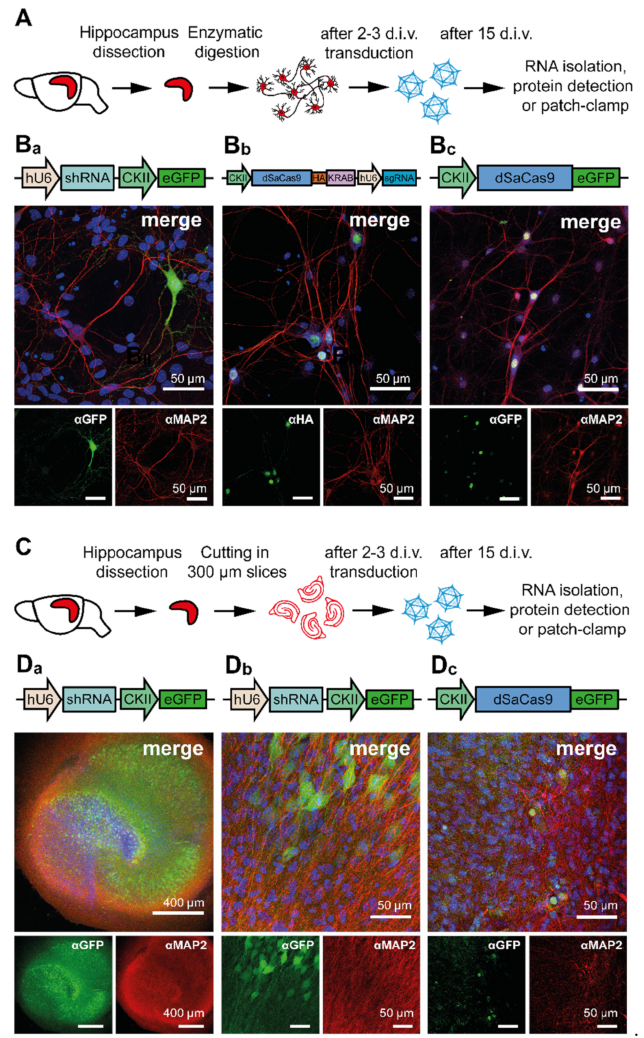
Figure 3. AAV-mediated expression of different constructs in primary hippocampal neurons (PHNs) and organotypic hippocampal slice cultures (OHSCs). ( A ) Schematic representation of the prepara- tion and transduction procedure of primary hippocampal neurons (PHNs). ( B a – B c ) Representative immunofluorescence images of rAAV9-transduced PHNs expressing the ( B a ) eGFP reporter, ( B b ) HA- tagged dSaCas9, and ( B c ) eGFP-tagged dSaCas9. ( C ) Schematic representation of the preparation and transduction procedure for OHSCs. For details see Material and Methods. ( D a – D c ) Representative immunofluorescence images showing rAAV9-transduced OHSCs expressing the eGFP reporter ( D a , D b ), or eGFP-tagged dSaCas9 ( D c ). The eGFP, HA-tag, and the neuron-specific microtubule-associated protein 2 (MAP2) protein were immunostained with specific anti-GFP, anti-HA, and anti-MAP2 antibodies combined with fluorescently labeled secondary antibodies (eGFP and HA-tag, green; MAP2, red). Nuclei were labeled with TOPRO (blue). Schematic of AAV-delivered constructs are displayed above the merged immunofluorescence